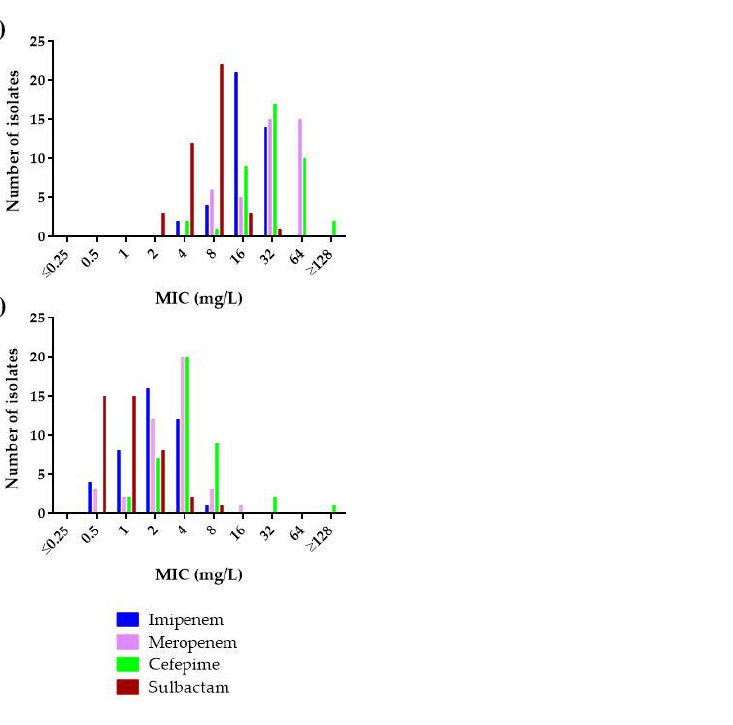
Figure 6. Comparative analysis of the activity of imipenem, meropenem, cefepime, and sulbactam alone ( A ) or in combination with LN-1-255 ( B ) against the set of CHDL-producing A. baumannii isolates.